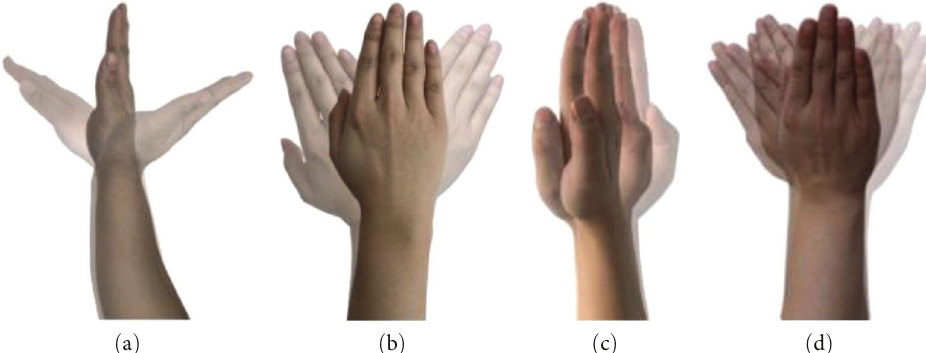
F IGURE 1: The movement of the forearm and wrist. (a) F/E of the wrist. (b) R/U deviation of the wrist. (c) S/P of the forearm. (d) Wrist